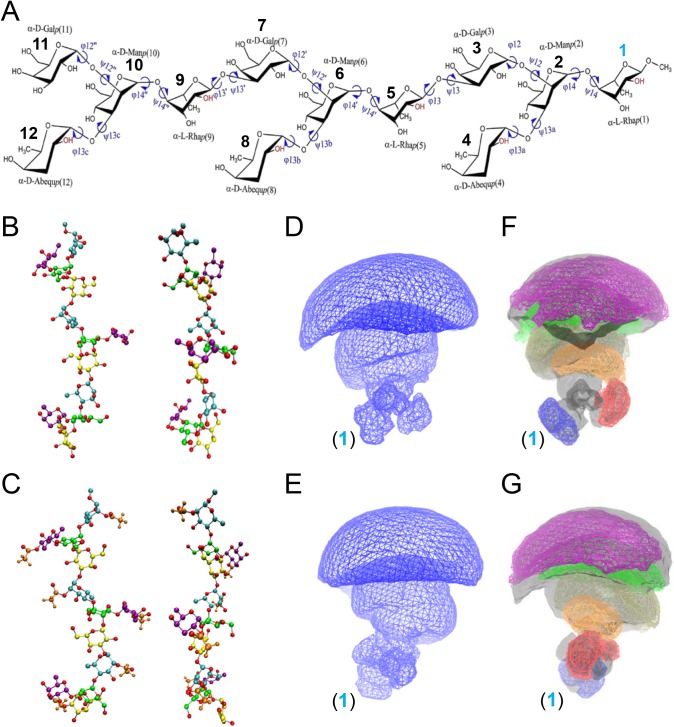
Chemical structure of the OPS used for computational simulations and chemical models and sampled volumes of the most prevalent conformational cluster “11111111”.(A) Structure of the base (O:4,12) 3-repeat STm polysaccharide unit used for computational analyses. Individual monosaccharide units are indicated numerically, with the reducing end rhamnose (Rha) designated as (1, blue). The representative O-acetylated polysaccharide was constructed with the hydroxyl group substituted by an acetyl at the C2 position of both α-D-Abequp and α-L-Rhap (-OH, red). (B,C) Structural models of GL cluster “11111111” displaying 90° of rotation around the carbohydrate stem for the base (B) and O-acetylated base (C) polysaccharides. The acetyl group is shown in brown, glucose in blue, mannose in green, galactose in yellow, abequose in purple, and rhamnose in cyan. For clarity, all hydrogen atoms are omitted except those on the acetyl group. (D,E,F,G) 3D spatial distributions (wire frame) displaying 90° of rotation around the carbohydrate stem for the base (D,E) and O-acetylated base (F,G) polysaccharides for all non-hydrogen atoms. The reducing end Rha (1, blue), indicated at the base, is approximated as linked to the core polysaccharide or preceding OPS repeat. Conformational flexibility increases progressively relative to the reducing end anchor point. The base polysaccharide backbone is identified by a transparent grey surface overlaid with the individual O-acetyl groups in color for monosaccharides (1) [blue], (4) [red], (5) [orange], (8) [tan], (9) [green] and (12) [purple]. Contour levels are set to 10−6 for the full polysaccharide and to 10−5 for the individual acetyl groups.